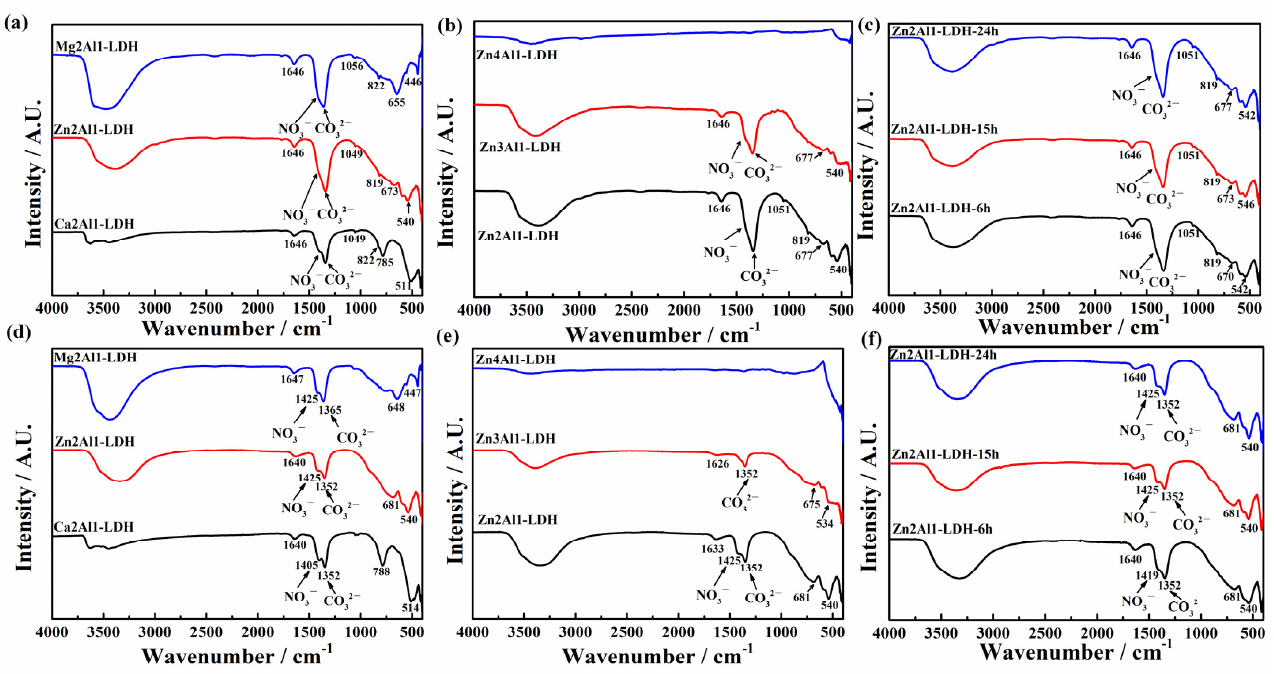
Figure 9. The FTIR results of different LDHs samples: ( a – c ) as-prepared; ( d – f ) after immersion in 0.02 mol/NaCl for 40 h.